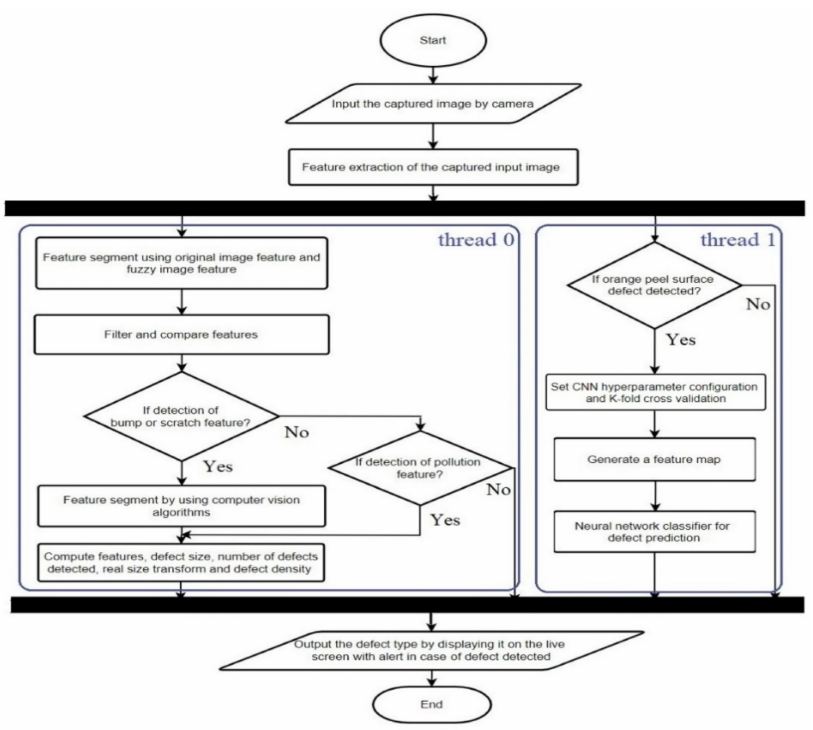
Figure 4. Flowchart for the System Model length and FOV settings. So all cameras evaluating simultaneously and will be displayed on live screen output. The detailed discussion for the AI landing is in Section 5.3.